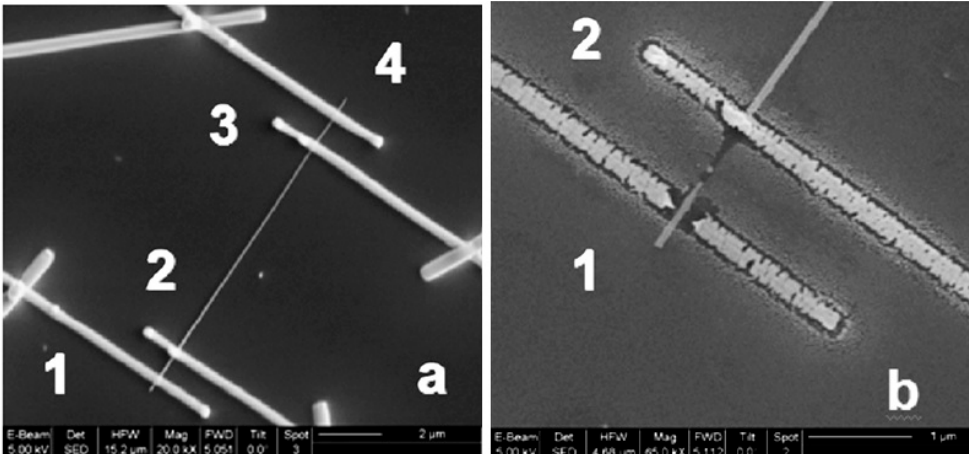
Figure 20. ( a ) A fabricated FIB four-probes contacted SnO 2 nanowire and ( b ) a detail of the contact after an electrical failure likely caused by the excess of heat dissipation in the contacts. Reproduced with permission from Hernandez-Ramirez et al. [159]. Copyright 2007: Elsevier.